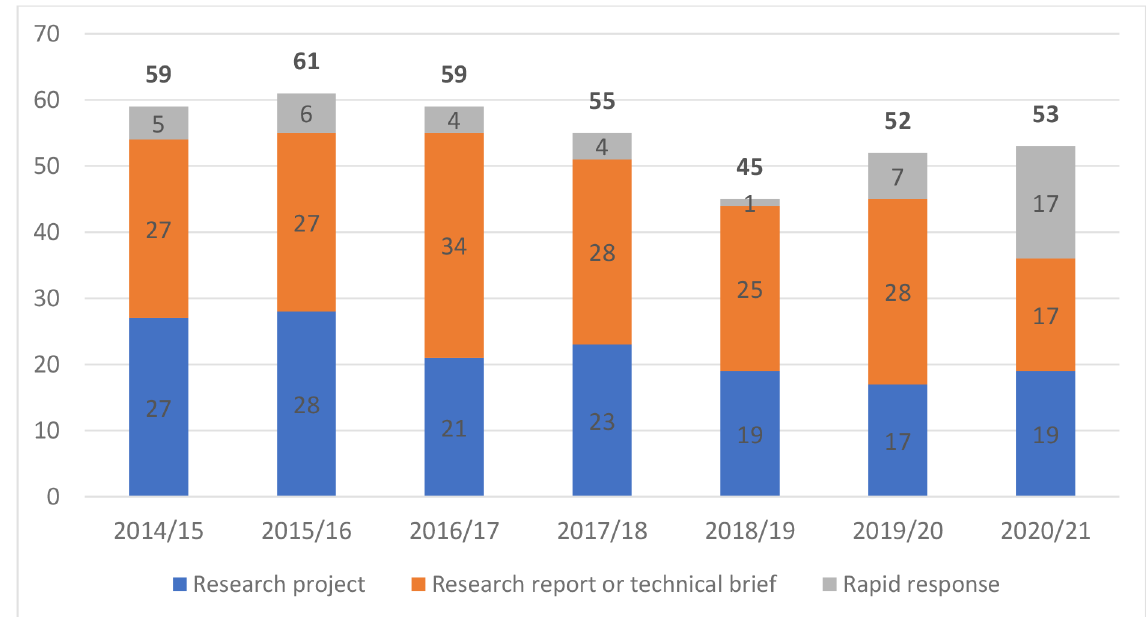
Figure 1: Types of AHRQ requests submitted by year